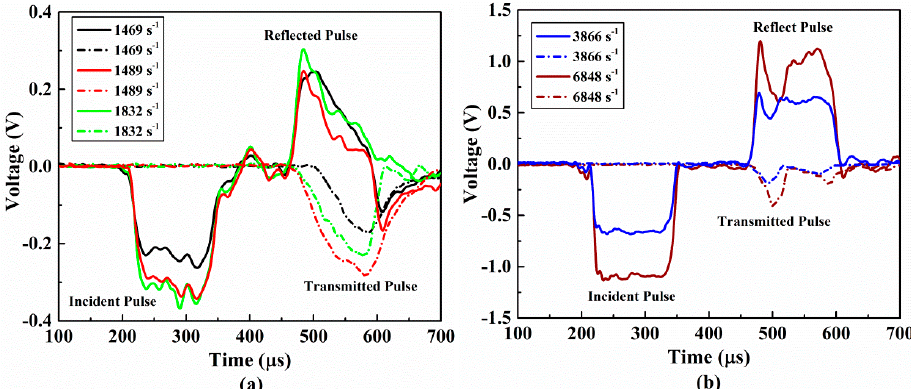
Figure 3. Voltage signals of a typical incident as well as reflected and transmitted pulses obtained from a conventional SHPB test. ( a ) The specimens have not undergo complete failure. ( b ) The specimens have undergone complete failure.